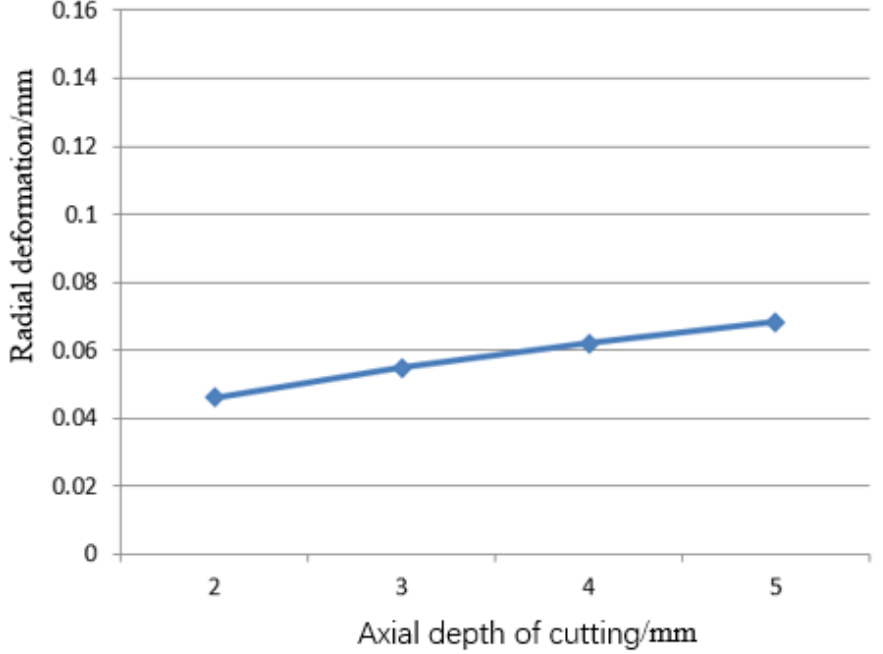
Figure 12. Influence of axial depth of cutting on machining deformation.